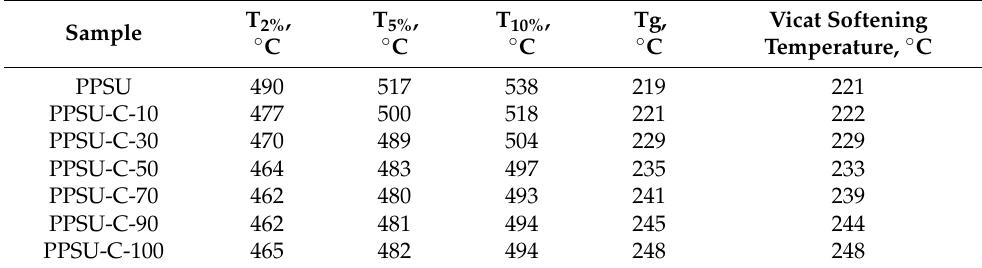
Table 2. Thermal properties of PPSU and